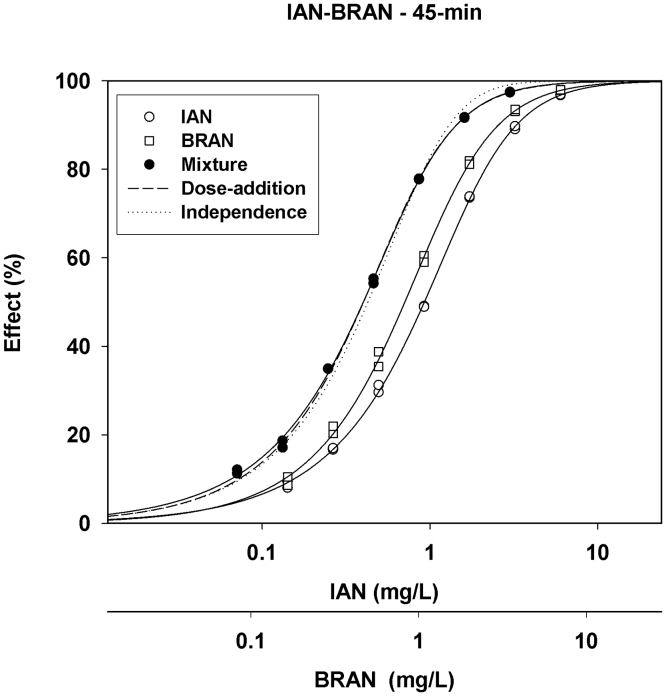
Concentration-effect curves for iodoacetonitrile (IAN), bromoacetonitrile (BRAN) and the IAN-BRAN mixture after 45-min of exposure, along with predicted curves for dose-addition and independence. Mixture toxicity was consistent with both combined effects models. The predicted dose-addition curve is almost completely covered by the mixture curve above about 35% effect.